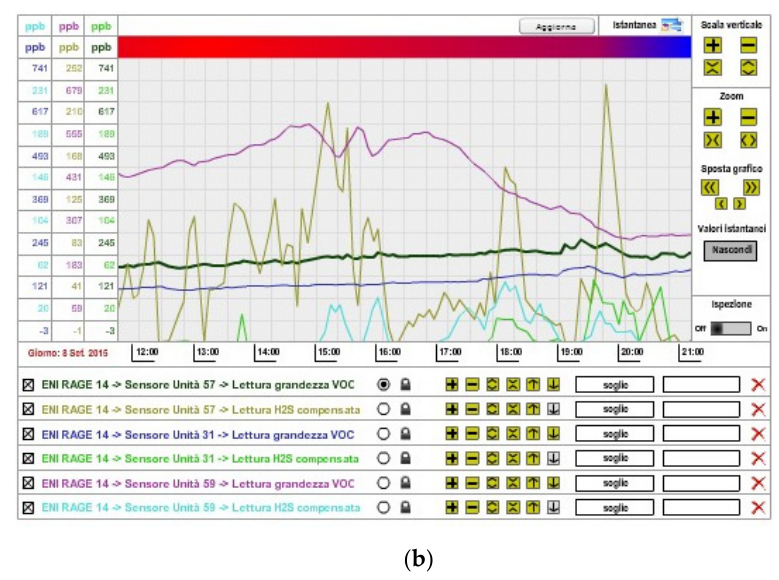
Figure 9. ( a ) VOC and ( b ) H 2 S concentrations in the wastewater treatment plant area.